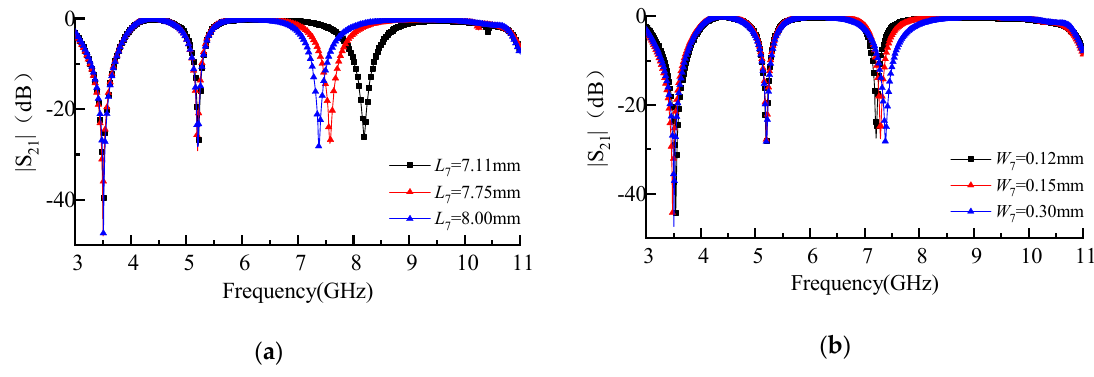
Figure 17. ( a ) Simulation results with different L 7 ( L 7 = 7.11 mm, f 3 = 4 GHz; L 7 = 7.75 mm, f 3 = 3.6 GHz; L 7 = 8 mm, f 3 = 3.5 GHz); ( b ) simulation results with different W 7 ( W 7 = 0.12 mm, f 3 = 3.4 GHz; W 7 = 0.15 mm, f 3 = 3.5 GHz; W 7 = 0.30 mm, f 3 = 3.7 GHz).